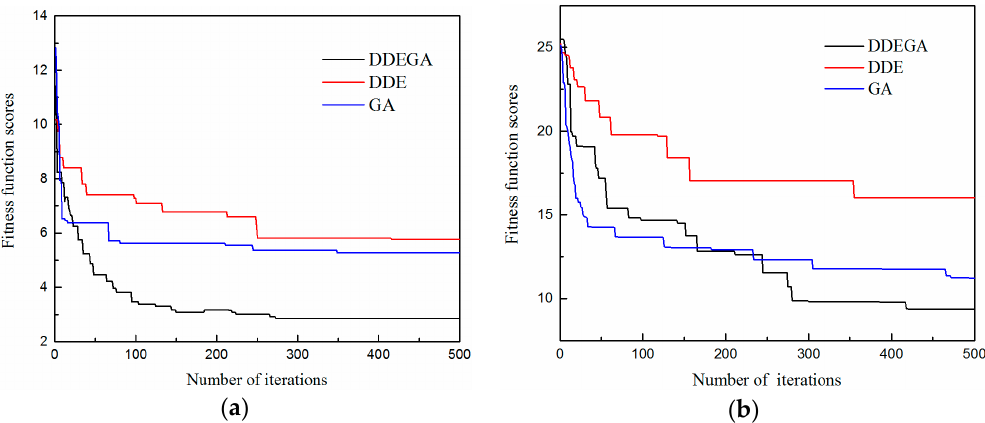
Figure 7. ( a ) Convergence of each algorithm for the first case study; and ( b ) convergence of each algorithm for the second case study.